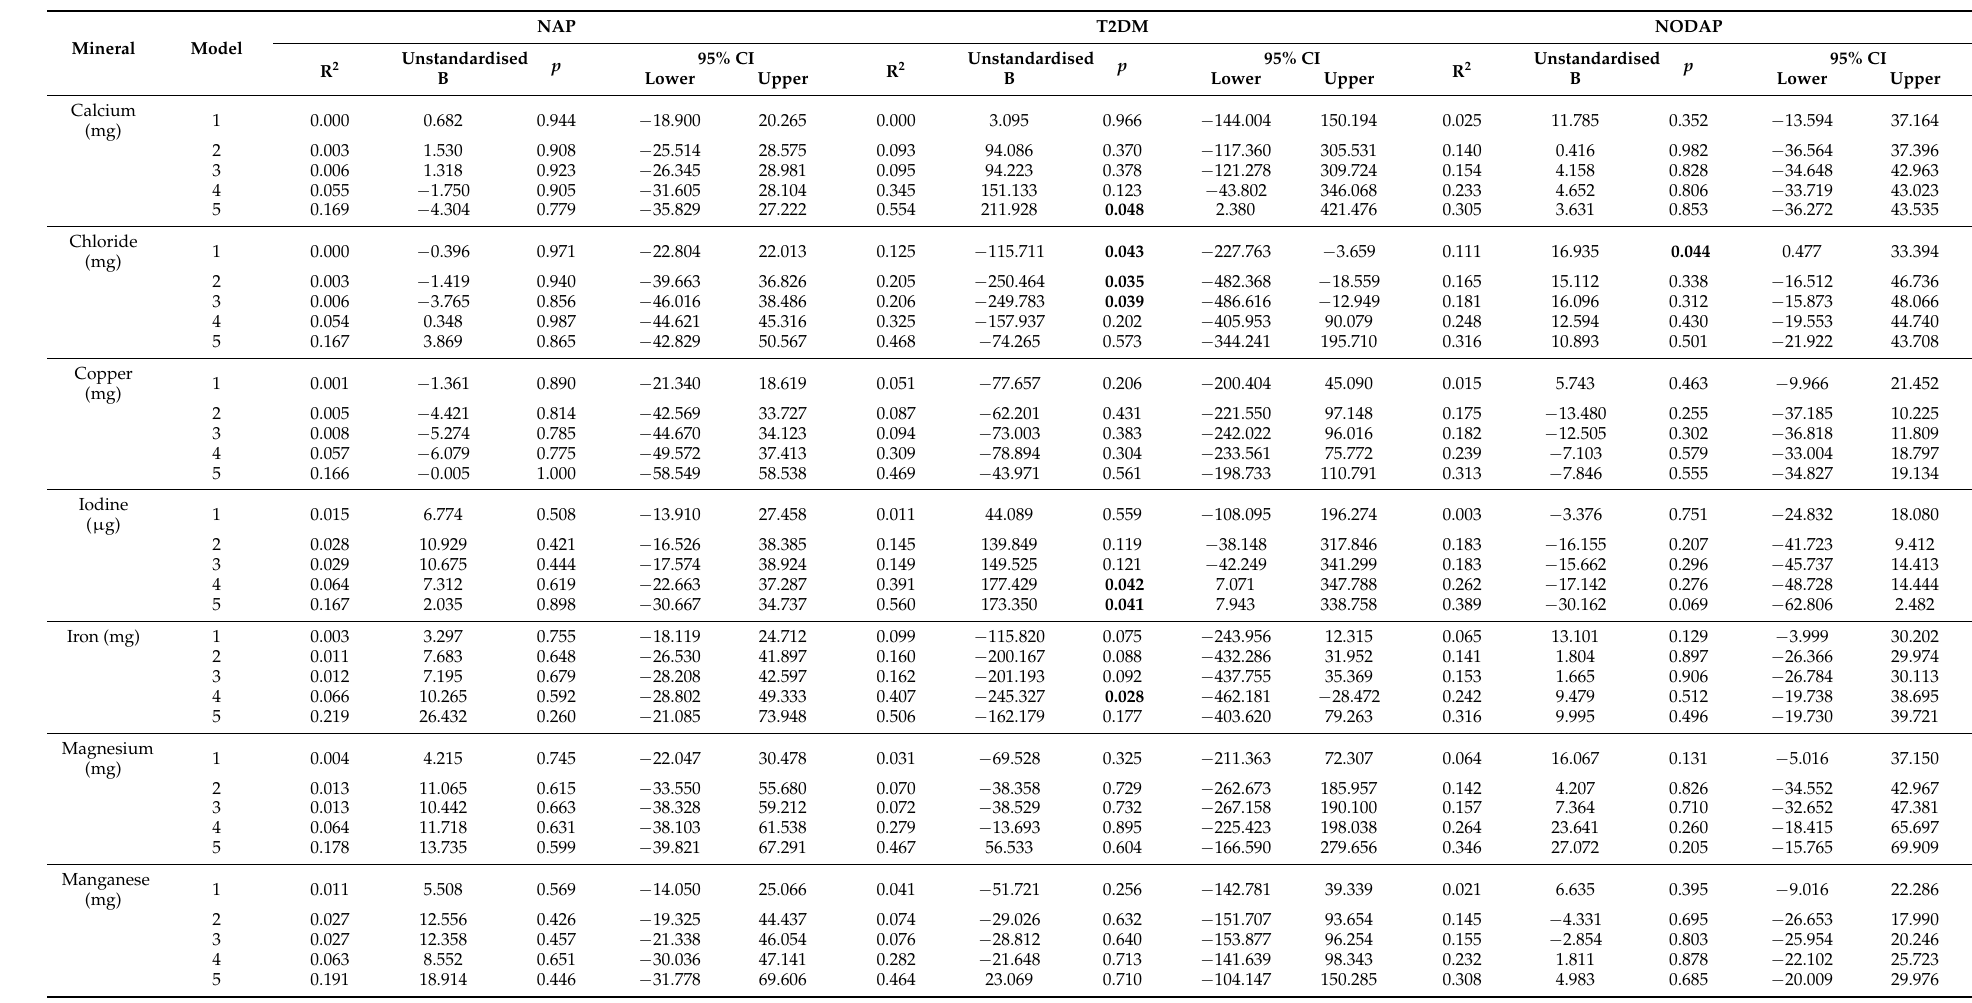
Table 5. Associations between habitual mineral intake and fasting insulin in the study